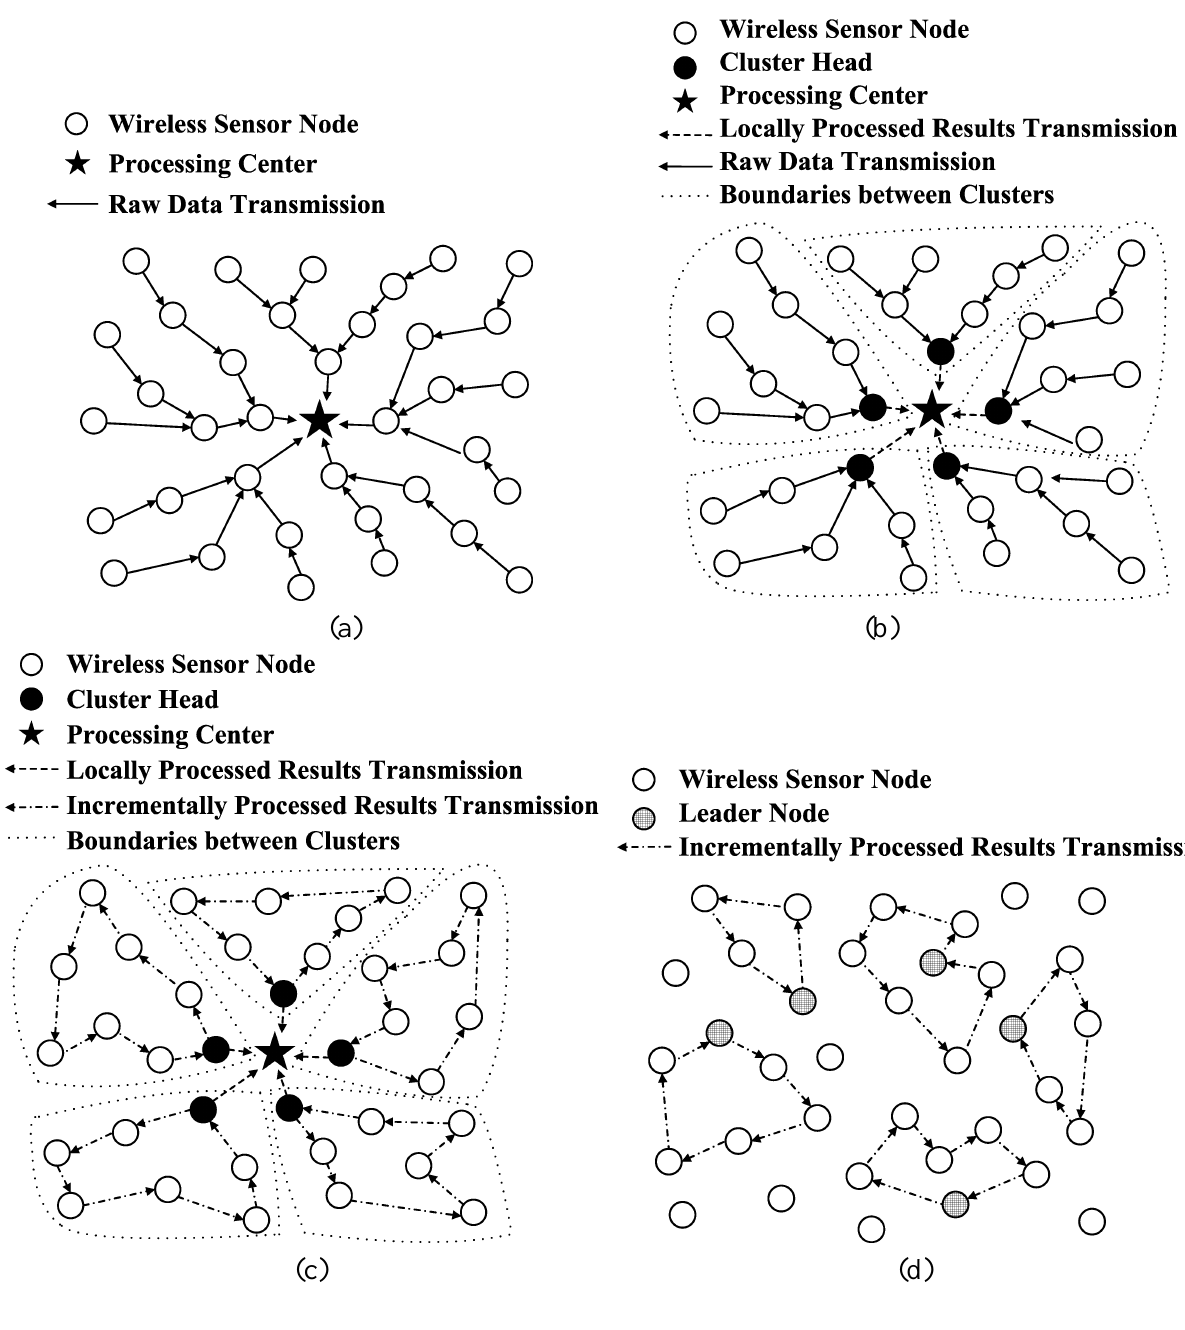
Figure 1. Different signal processing frameworks in WSNs: (a) centralized client/server framework; (b) distributed client/server framework; (c) distributed mobile agent framework and (d) distributed P2P